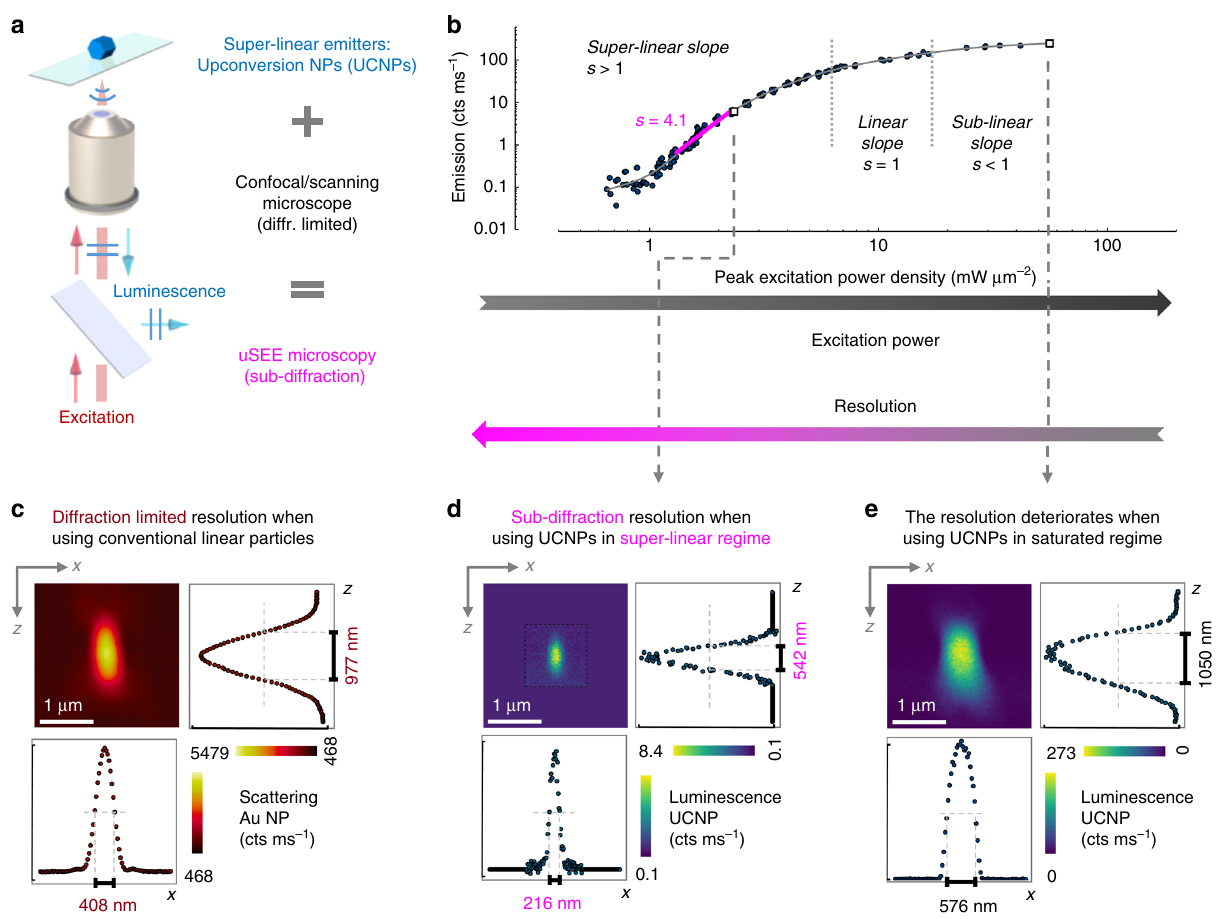
Fig. 1 3D sub-diffraction resolution achieved by SEE microscopy. a Sub-diffraction resolution can be achieved in a conventional confocal microscope when using super-linear emitters, in our case upconversion nanoparticles (UCNPs of NaYF 4 : 20% Yb, 8% Tm). b The emission from the UCNPs at λ = 455 nm, exhibits a strong super-linear dependence on the excitation power, with a maximum of slope s = 4.1 in the low-power range. The open square symbols represent the peak power densities at which the measurements in panel ( d - e ) were obtained. c Experimentally, the diffraction limit of the setup is determined from the PSF of the excitation beam, obtained by scanning a gold particle through the beam and recording the scattering intensity at each point. The diffraction-limited lateral ( x direction) resolution is 408 nm and the axial ( z direction) resolution is 977 nm as shown in the corresponding cross sections. In contrast, when using non-linear emitters ( d - e ), the size of the PSF, representing the resolution, changes depending on the excitation power. d In the low-power super-linear range we achieve sub-diffraction imaging (uSEE microscopy), with lateral resolution 216 nm ( λ /4.5 compared with the diffraction limit of λ /2.4) and axial resolution 542 nm ( λ /1.8 compared with the diffraction limit of λ ). e In the high-power saturation regime the resolution is worse than the diffraction limit. The dashed black box in ( d ) indicates the span of the experimentally measured area. The area outside of the black box contains a fl at background equal to the average background in the measured area. This facilitates the visual comparison of panels ( c –